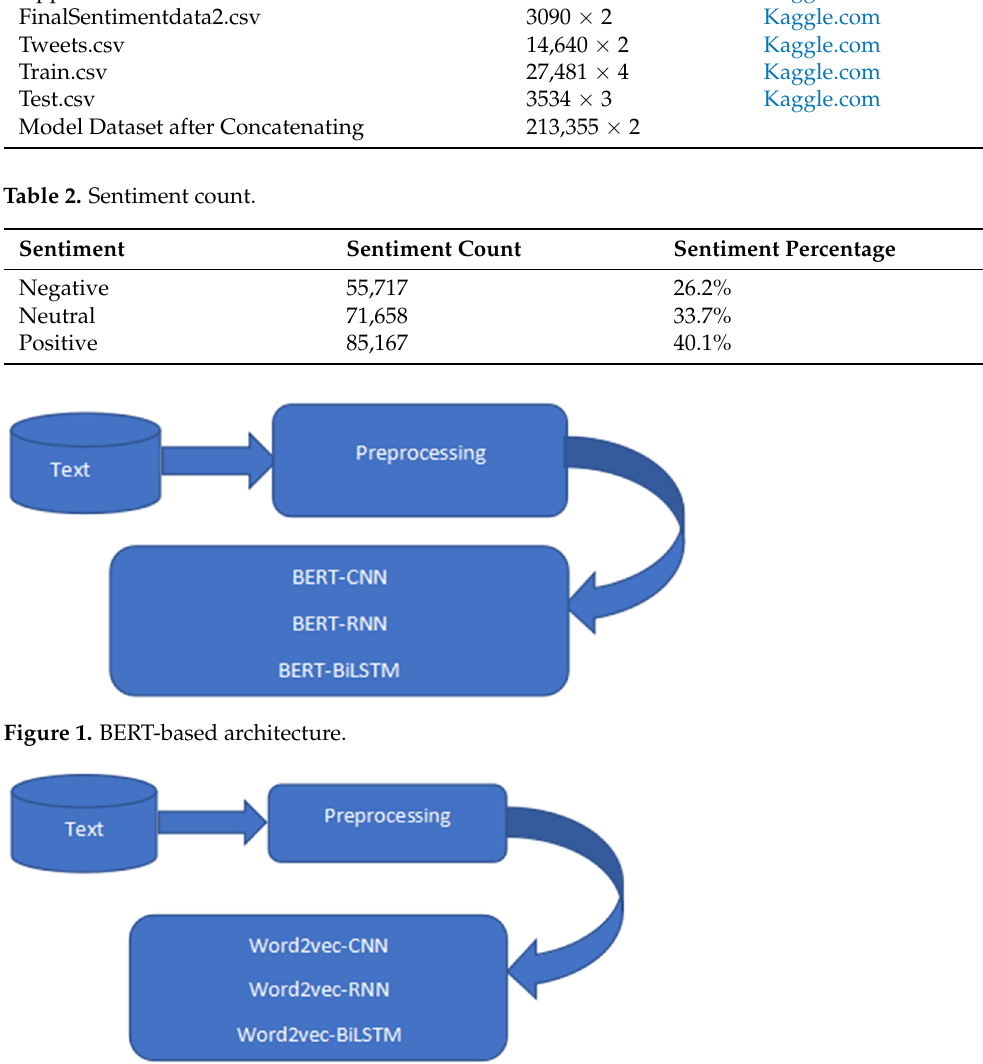
Figure 2. Word2Vec-based architecture .